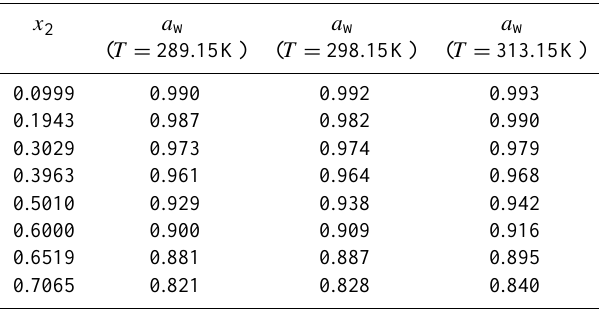
Table A5. Bulk water activity (a w ) measurements a of water (1) + 2,2,6,6-tetrakis(hydroxymethyl)-cyclohexanol (2) solutions at three dif- ferent temperatures. Solution compositions are given in mole fraction of the organic component (2), x 2 . x 2 a w a w a w